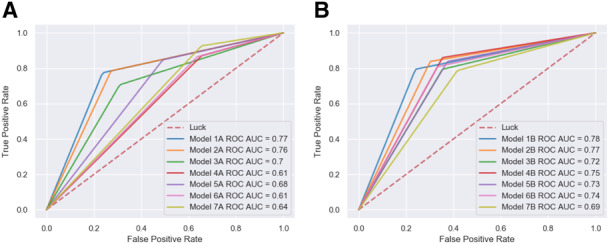
ROC AUC curves for selected models for P1 dataset (A) and P2 dataset (B)